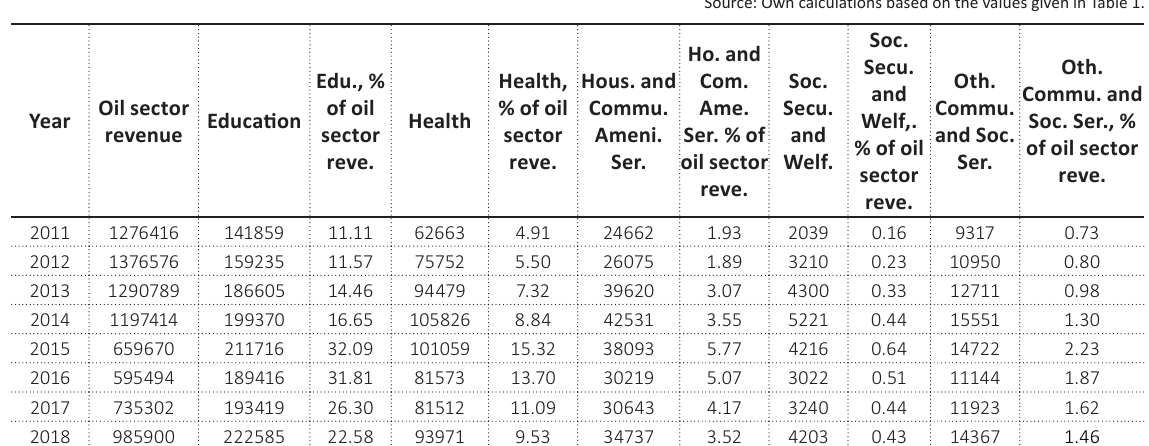
Table A4. Public spending avenues proportionate to oil sector revenue (%)